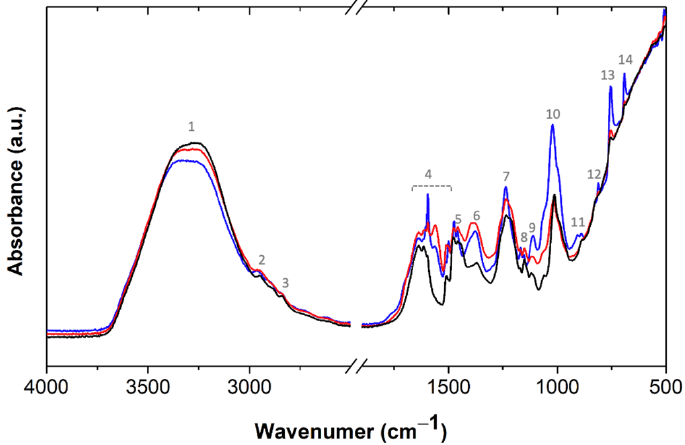
Figure 6. Normalized FTIR spectra of phenolic resins without lignin (black) and with 50 wt% lignin- LA, with 2 wt% NaOH (blue) and 4 wt% NaOH (red). The peaks of interest are highlighted, and their assignment is discussed in the text.